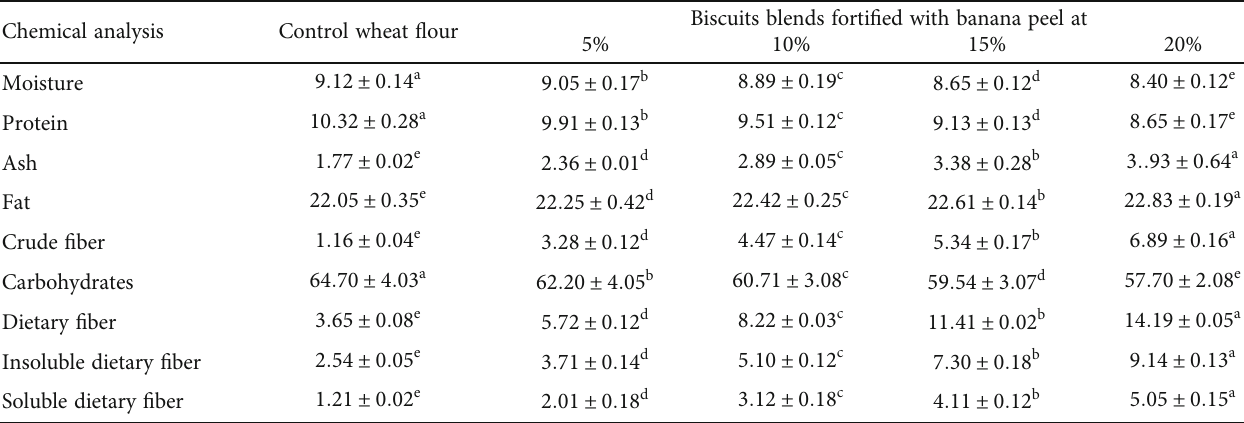
Table 2: Nutrition values of biscuits blends (g/100 g dry weight).